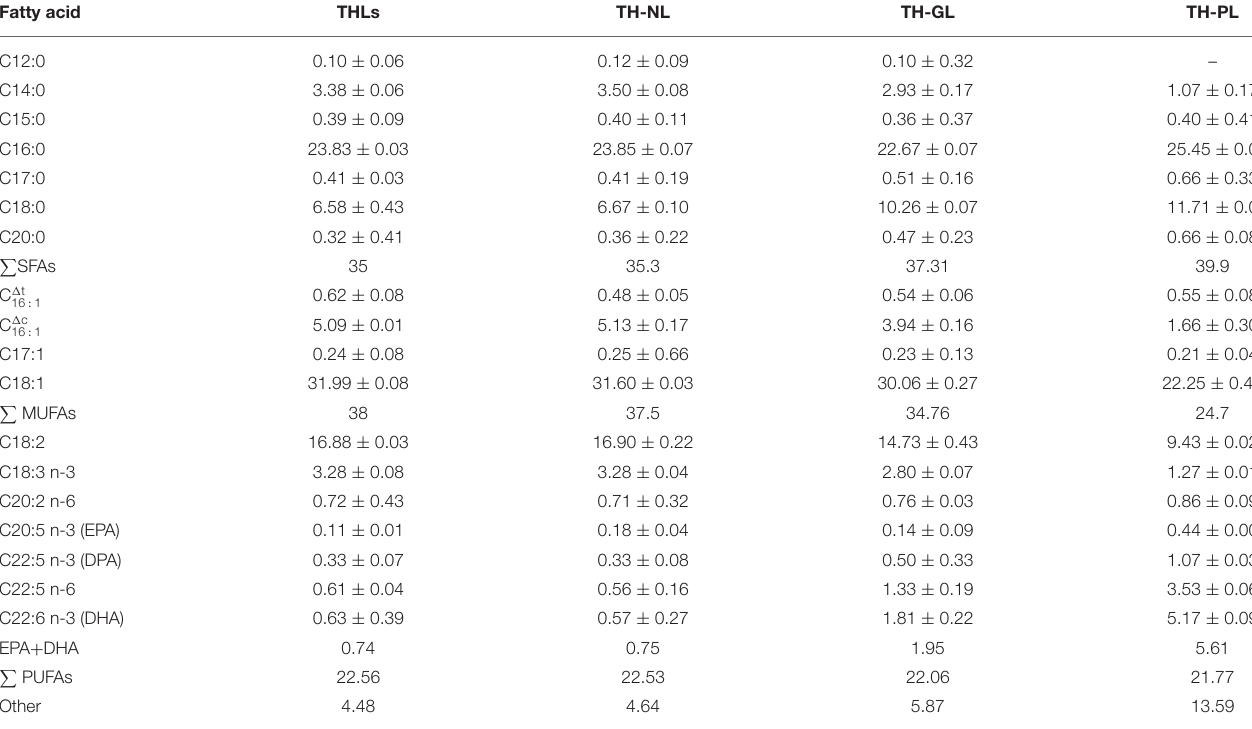
TABLE 2 | Fatty acid composition (%) of TL, NL, GL, and PL a . Fatty